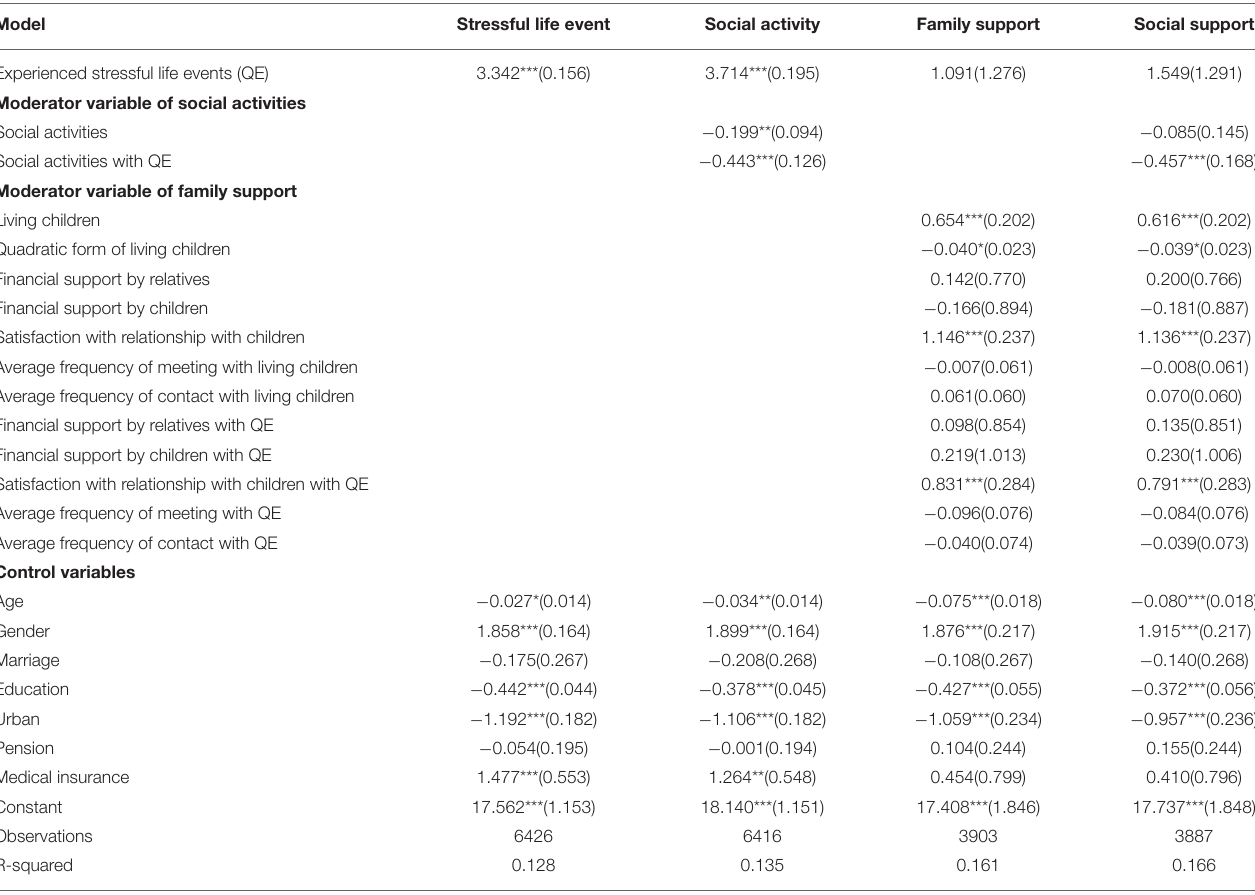
TABLE 5 | Results from multiple regression model of risk factors and social support when experienced stressful life events after propensity score matching (PSM) analysis predicting depression (Robustness